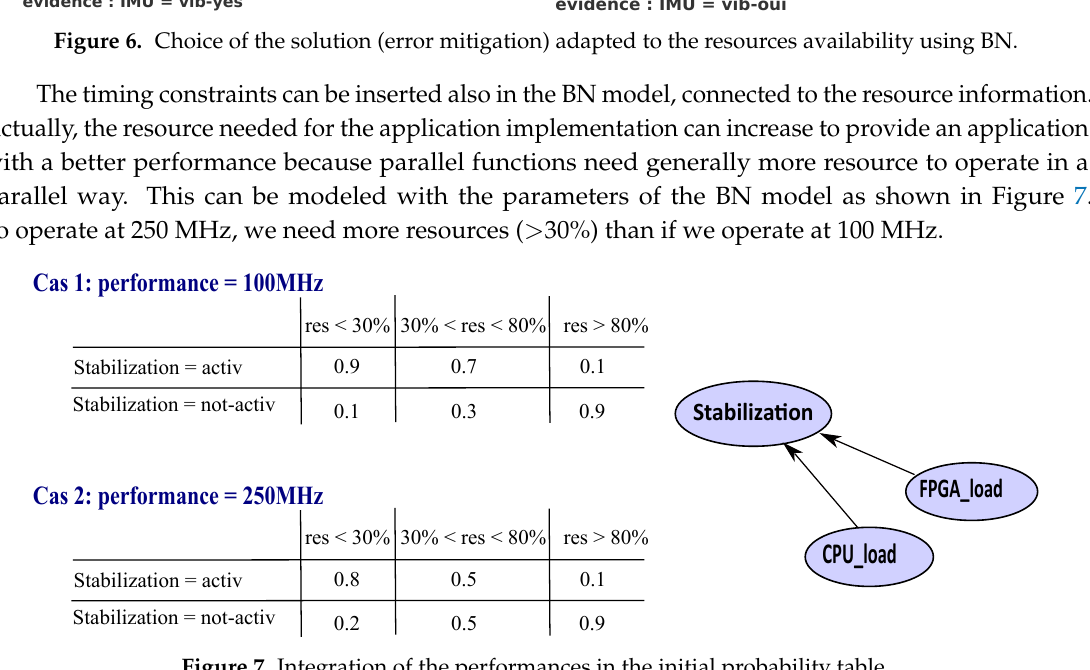
Figure 7. Integration of the performances in the initial probability